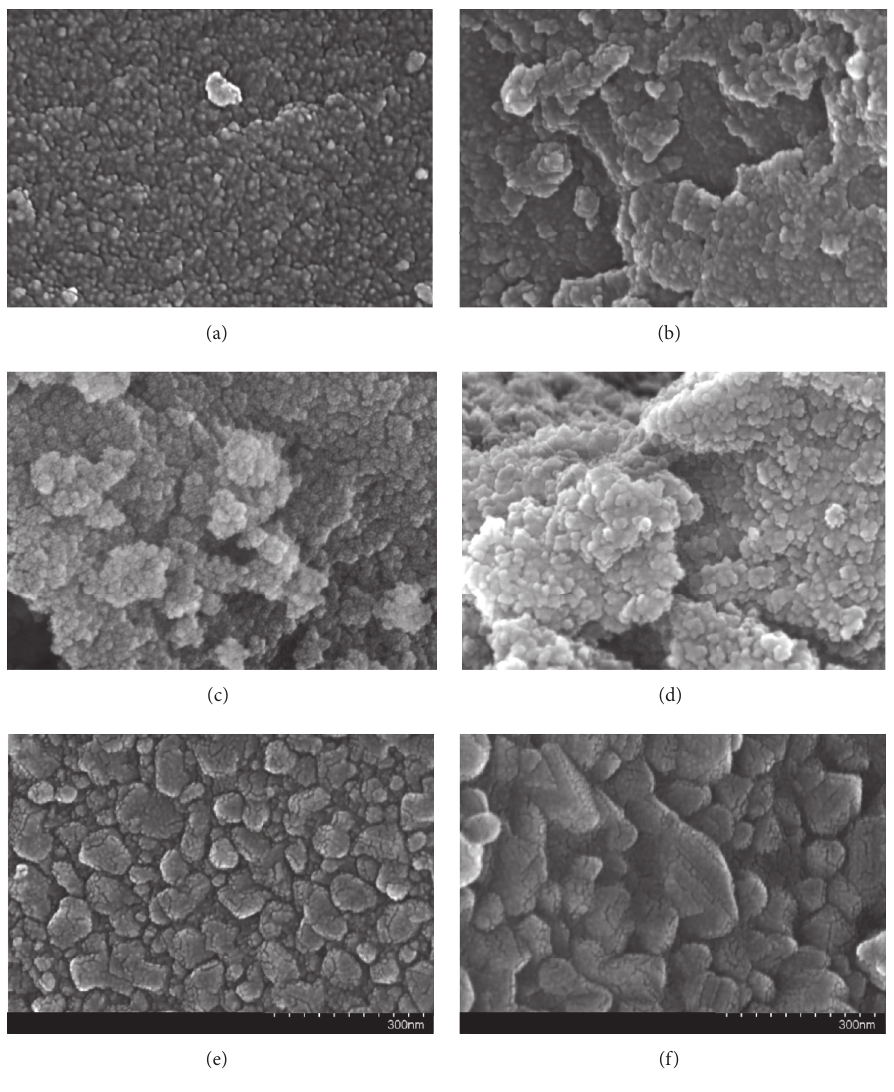
Figure 8: SEM images of gels obtained using 1,2-ED, 1,3-PD, and 1,4-BD, annealed at 700 and 900 ∘